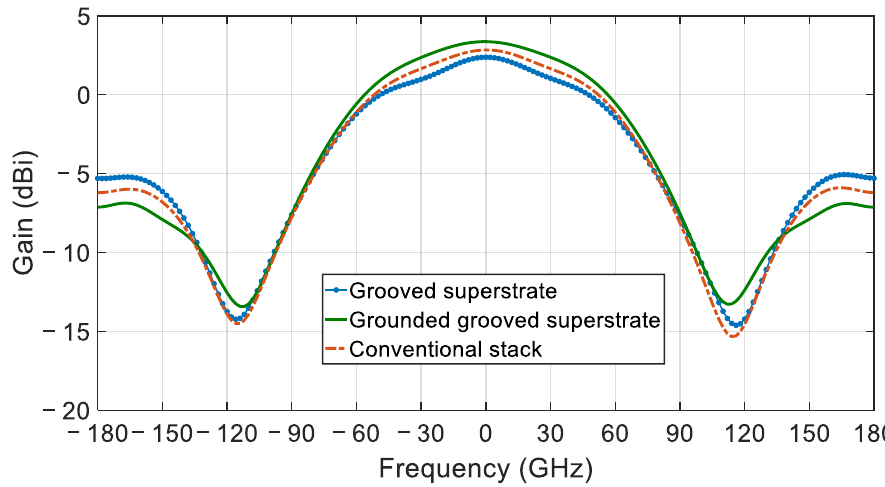
Figure 7. Comparison of the simulated gain profile for the single element CDRA for conventional, grooved superstrate and the grounded grooved superstrate stack.